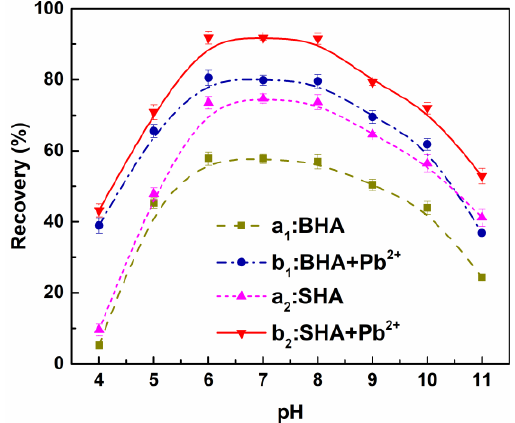
Figure 2. Effects of pH on ilmenite flotation recovery in the absence and presence of Pb 2+ ions, using salicylhydroxamic acid (SHA) and benzohydroxamic acid (BHA) as collectors (C(BHA) = 2 × 10 −4 M, C(SHA) = 2 × 10 −4 M, C(Pb 2+ ) = 1 × 10 −4 M).